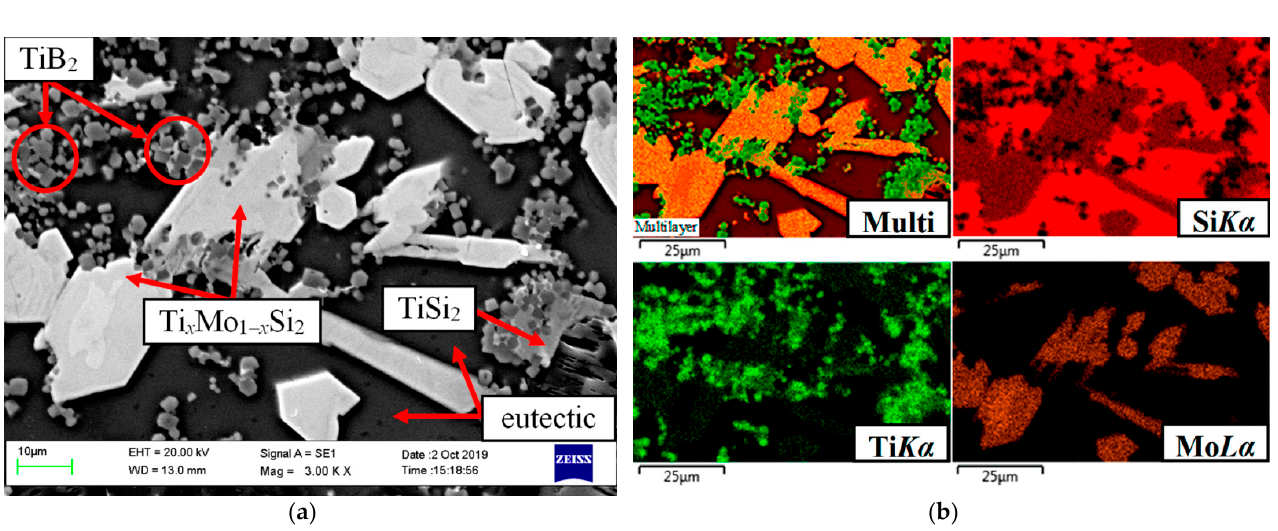
Figure 1. Microstructure of the coating in the initial state ( a ) and the distribution of elements in characteristic X-ray radiation ( b ). The lower limit of the adhesive bond strength of the coating with the substrate was ~20 MPa (separation along the adhesive joint).